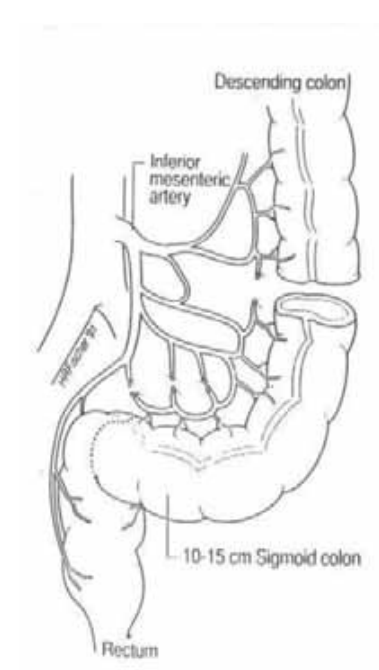
figure 1 - (A): Isolation of 12-15 cm of sigmoid colon, (B): The bowel segment has been positioned to be anastomosed to vulvar